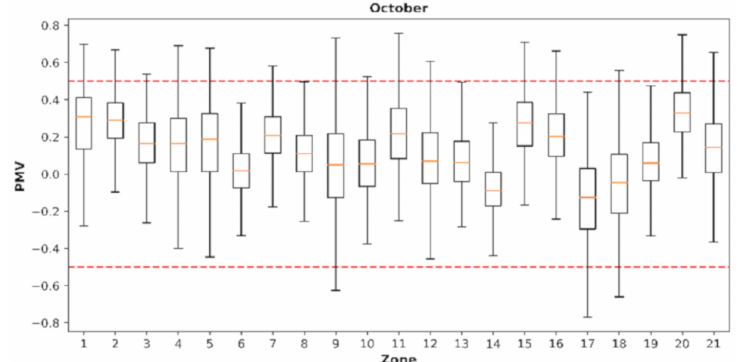
Figure A13. PMV in